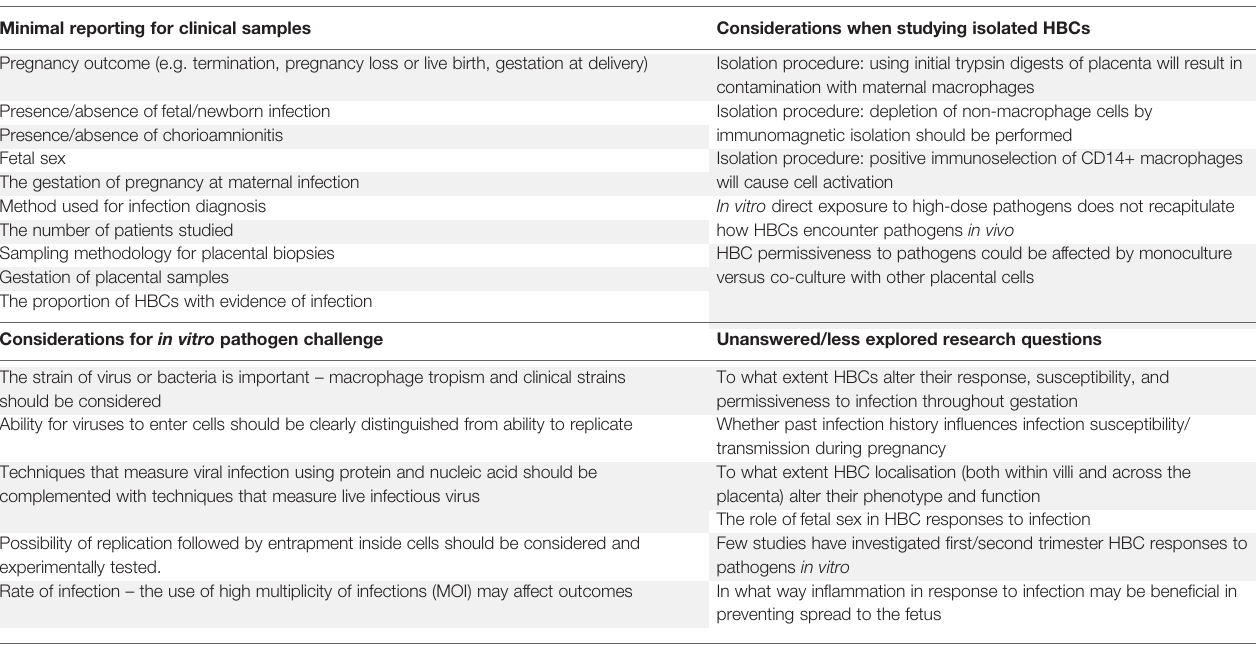
TABLE 6 | Considerations for future microbial studies in placental